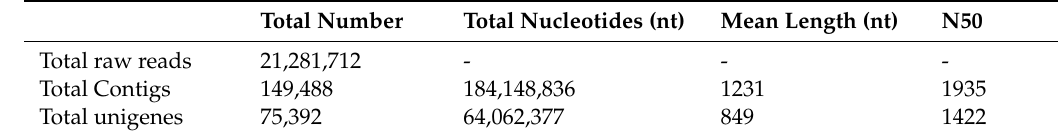
Table 2. Summary of the transcriptome of P.